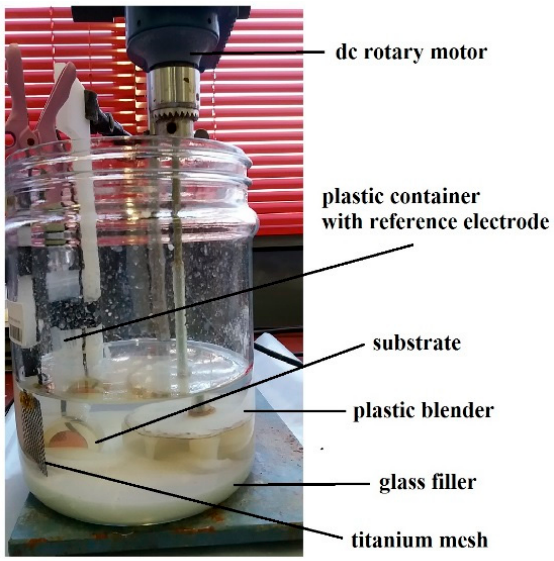
Figure 1. Test rig used for erosion – corrosion experiments.